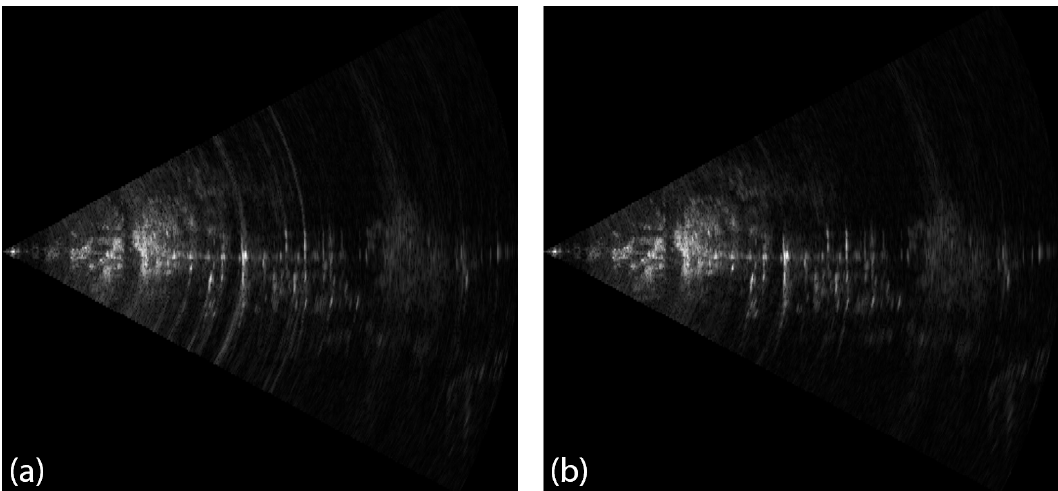
Figure 5. ( a ) Scan area of the GB-TomoSAR experiment overlain by Google Map image and ( b ) 3-D conceptual diagram of image cone.